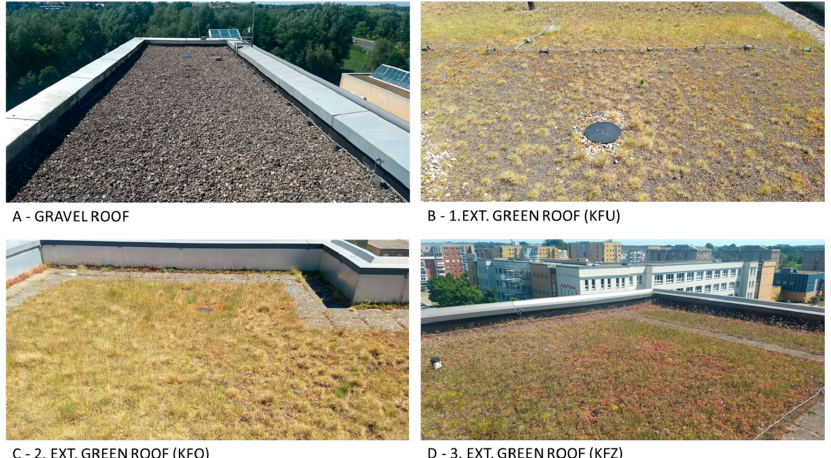
Figure 3. Measurement fields with dipping buckets underneath the experimental extensive (ext.) green